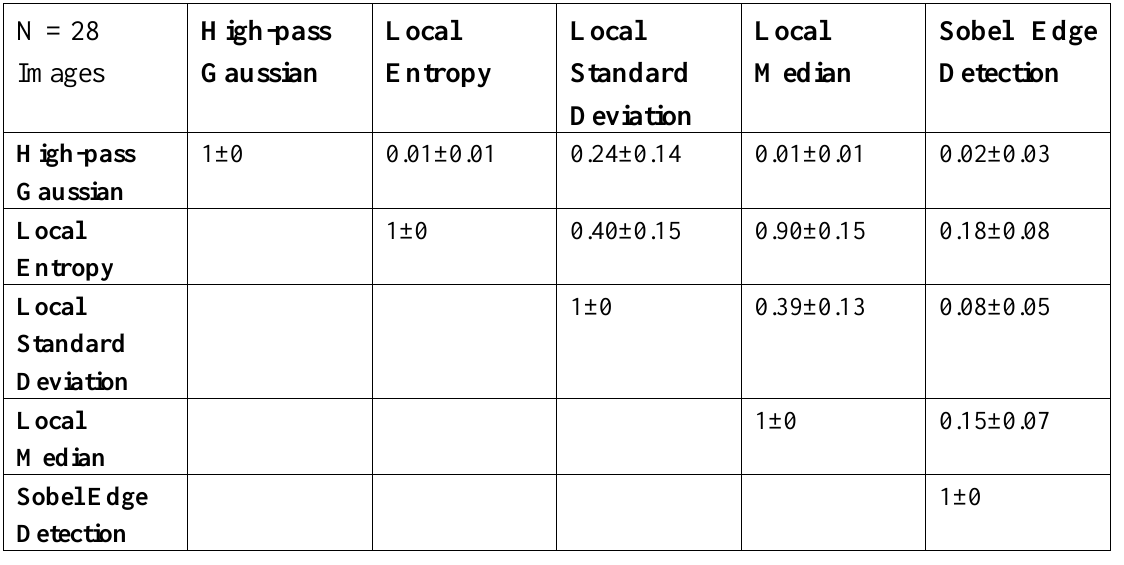
Table 3. Correlation matrix for the output of the edge detection and high-pass filters used in feature extraction. Each cell contains the mean and standard deviation over the set of 28